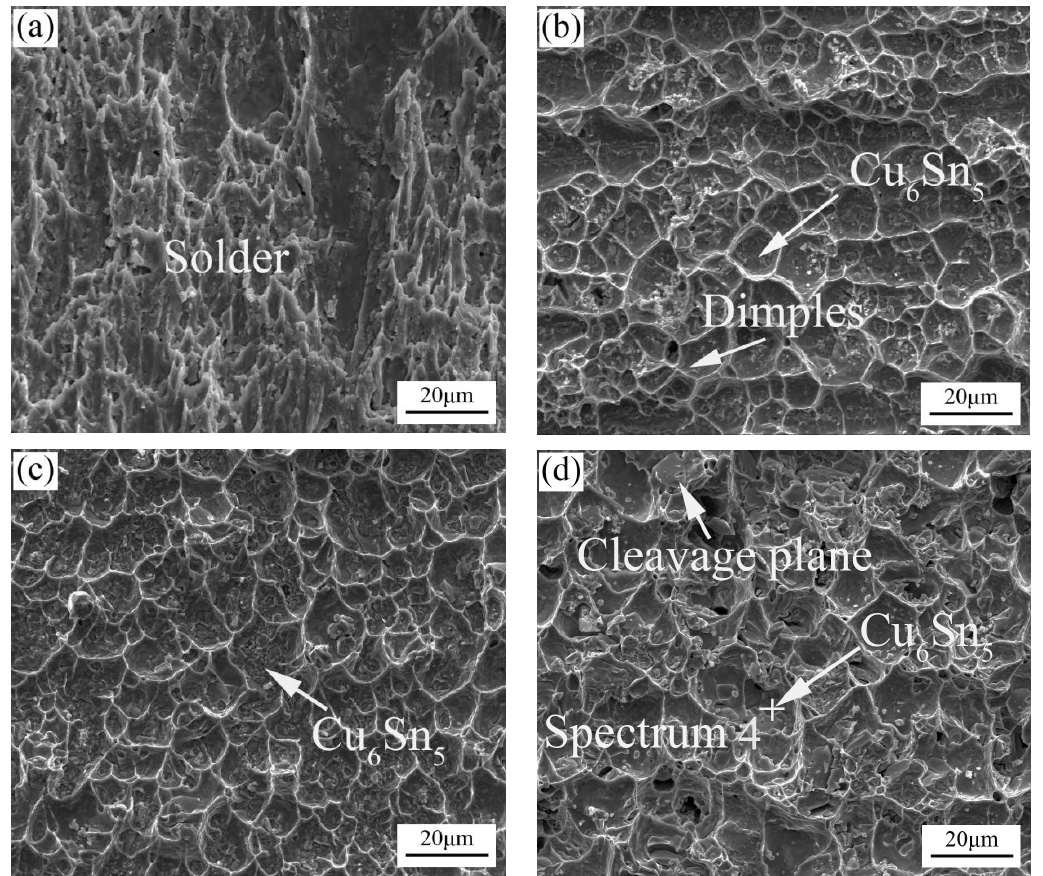
Figure 6. Top views of the shear fracture surfaces for the solder joints at a 400-ms ultrasonic bonding time for different aging times: ( a ) 24 h; ( b ) 120 h; ( c ) 240 h and ( d ) 360 h.